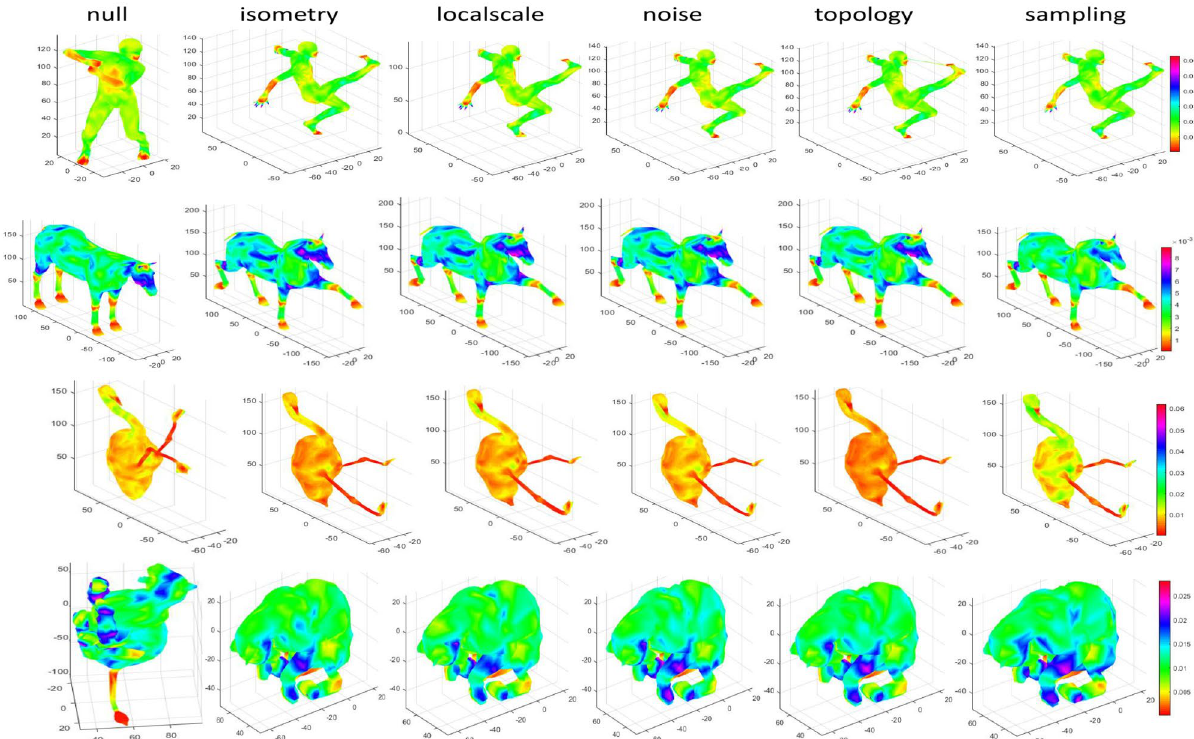
Figure 5. Robustness of SIMHW based on SHREC2010 and TOSCA dataset.